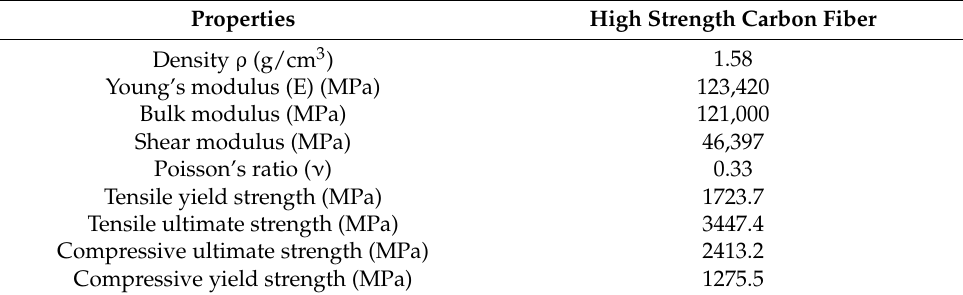
Table 3. Material Properties of high strength carbon